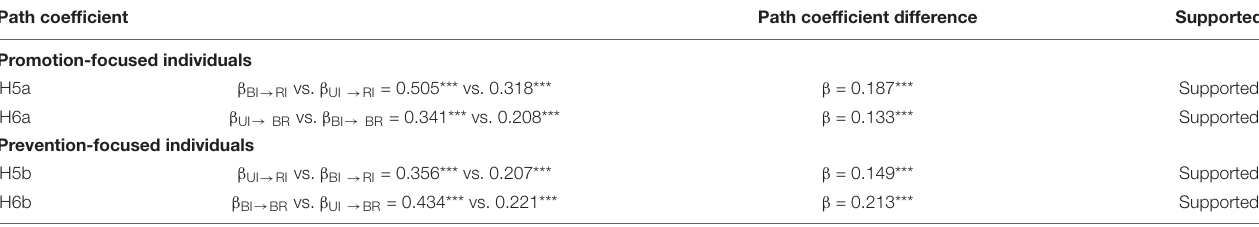
TABLE 9 | Post hoc analysis of regulatory fit